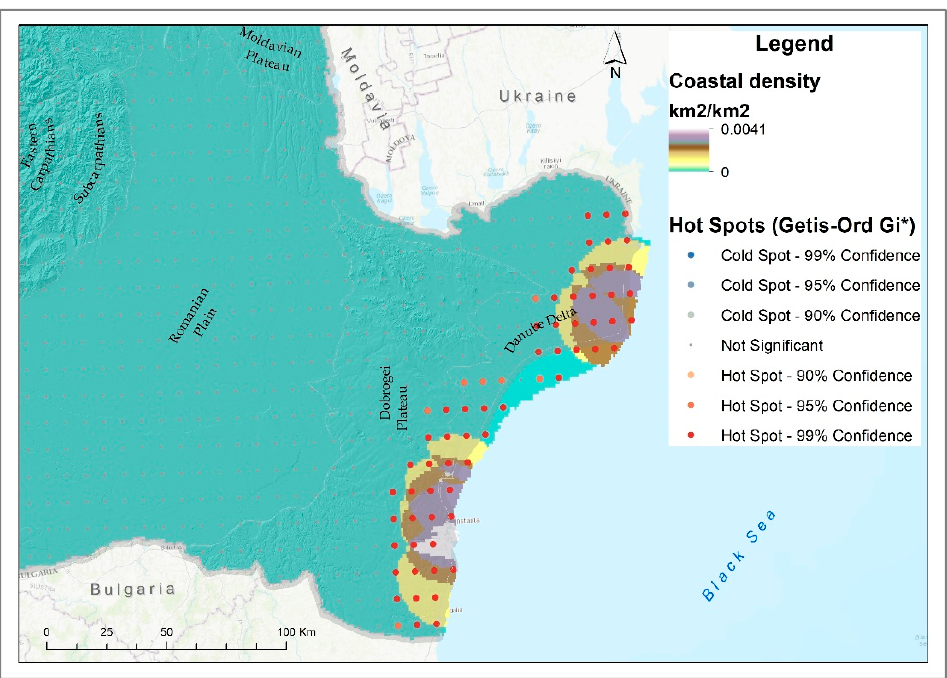
Figure 9. Coastal degraded ecosystem density and hotspot analysis.